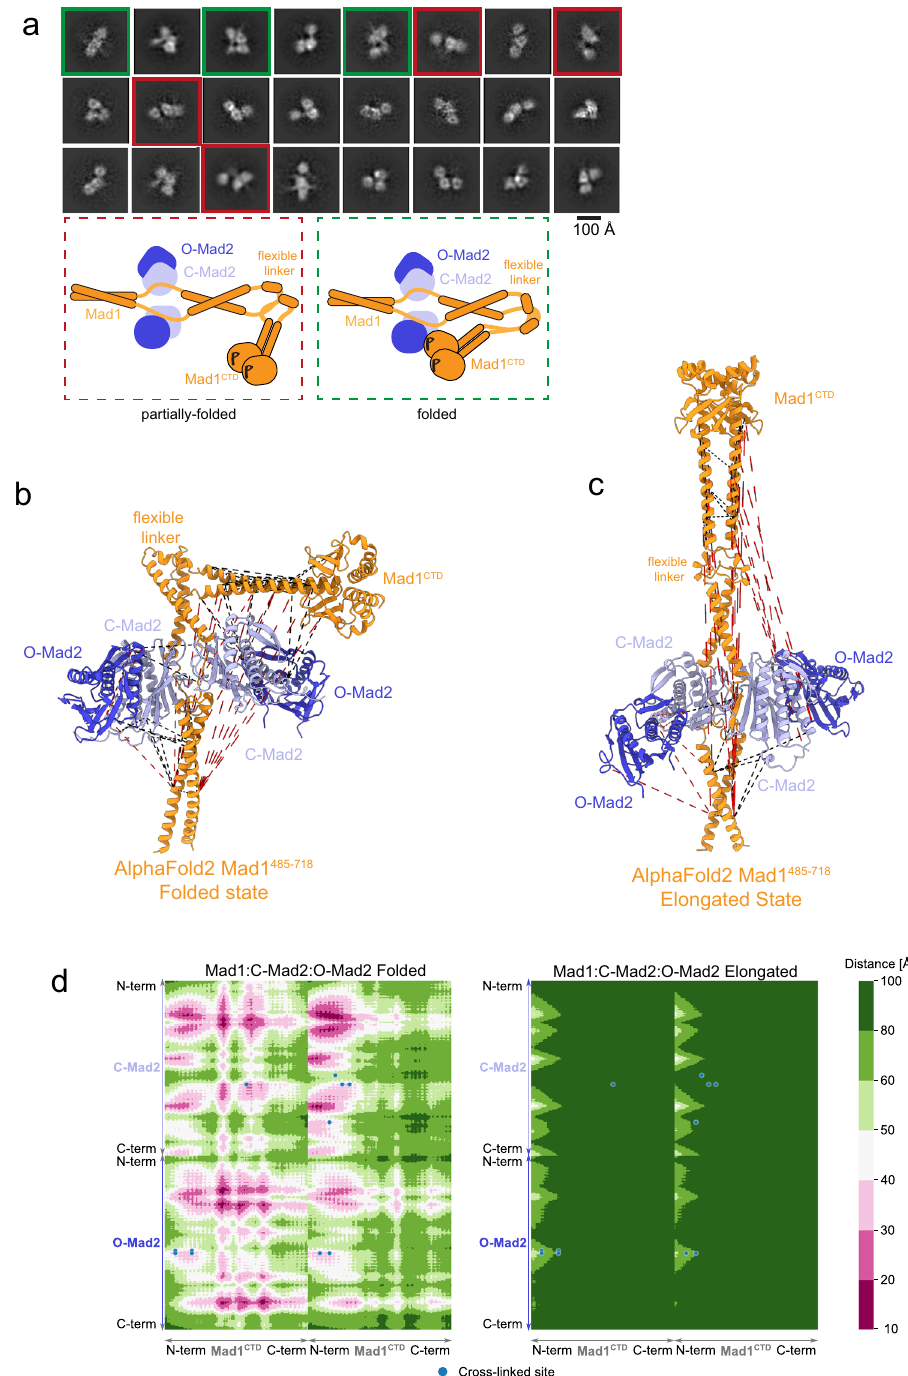
Fig. 6 | Fold-over within the Mad1:Mad2 complex. a 2D averages of BS3 cross- linked pMad1:C-Mad2:O-Mad2 complex by cryo-EM, representative of 125 2D clas- ses. Classes showing complexes that appear only partially folded are boxed in red, and classes showing complexes that appear fully folded are boxed in green. A schematic of the suggested partially folded and folded states seen in the 2D averages is shown below. b Identi fi ed cross-links for the phosphorylated Mad1:C- Mad2:O-Mad2 complex were mapped onto a folded Mad1 CTD state as predicted by AlphaFold2 (Supplementary Fig. 8d) where alignment of the folded AlphaFold2 Mad1 485 – 718 structure onto the crystal structure of Mad1 485 – 584 :C-Mad2 (PDB 1GO4) 23 and C-Mad2:O-Mad2 dimer (PDB 2V64) 26 was used to generate a model of the hexameric complex. Mad1 subunits (residues 485 – 718) are shown in orange,